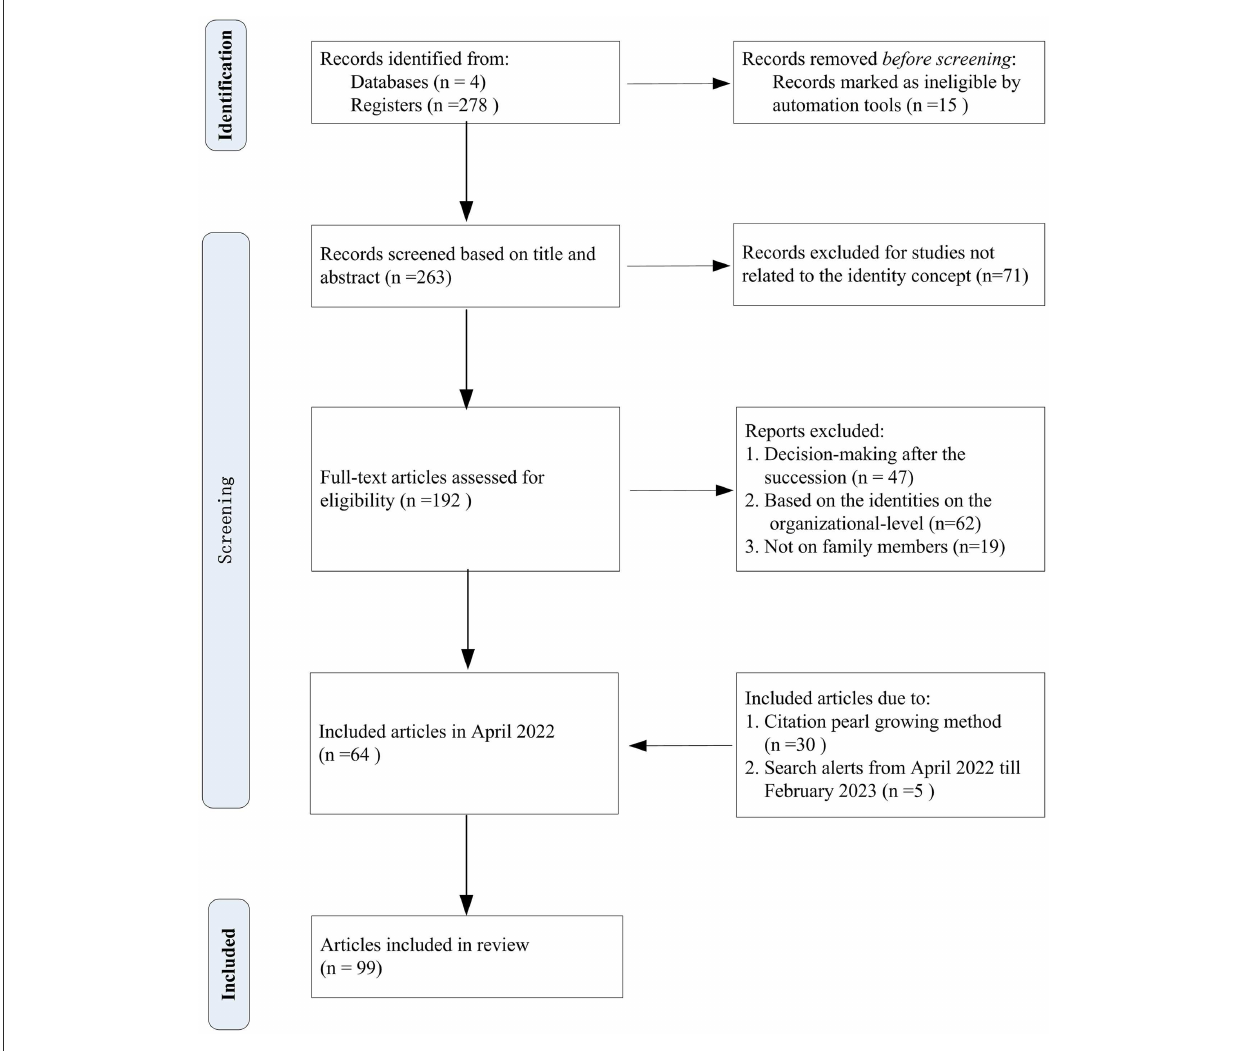
FIGURE2 Summary of article collection and screening, adapted from